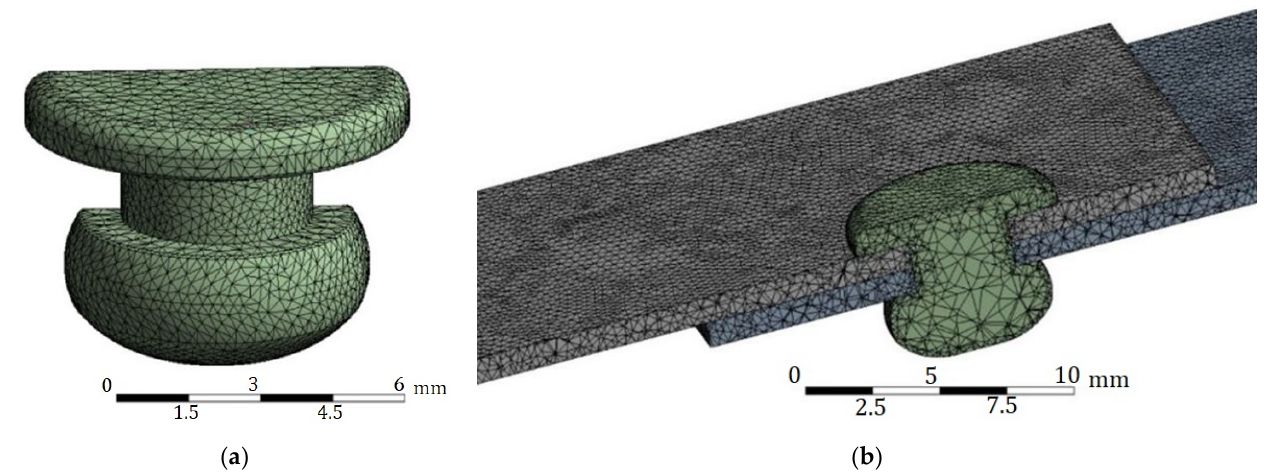
Figure 5. Mesh: ( a ) rivet; ( b ) riveted joint (cross section).